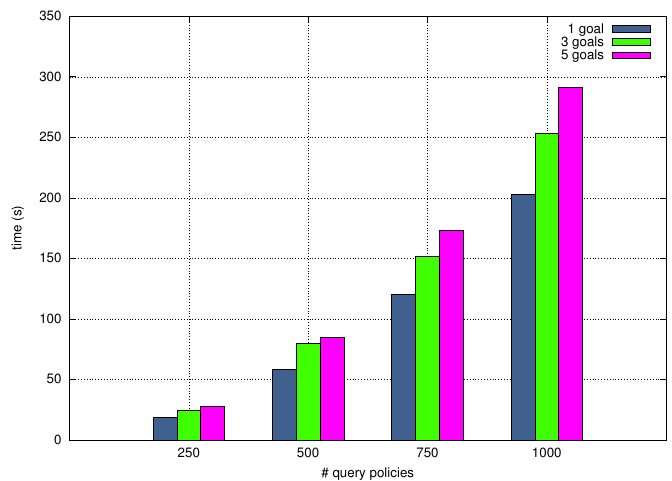
Figure 12. End-to-end processing time by granular